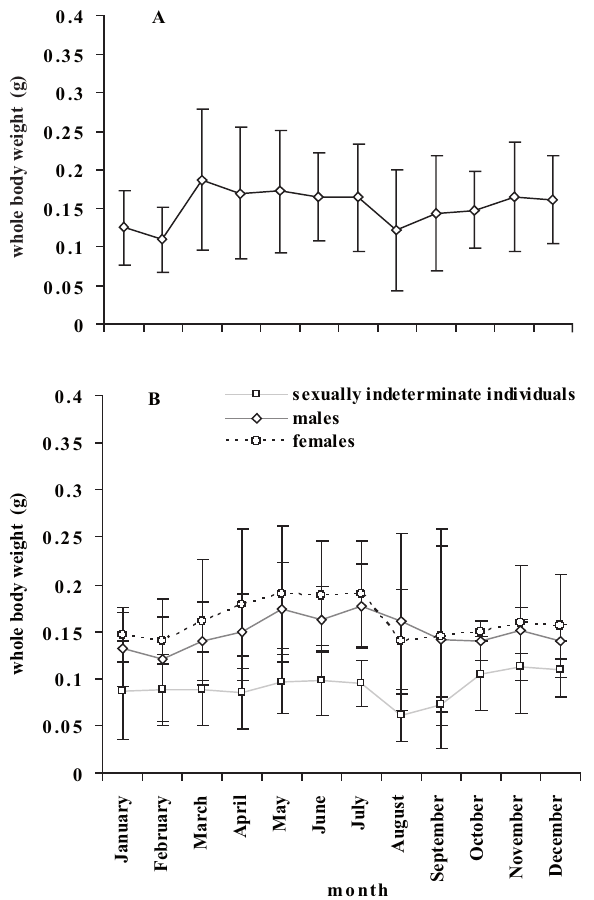
Fig . 6. – Monthly variation between January and December 2005 of mean individual whole body weight at Pointe Pescade. A: for all individuals, B: for the sexually indeterminate and differentiated individuals. Each data point represents mean ± standard deviation.